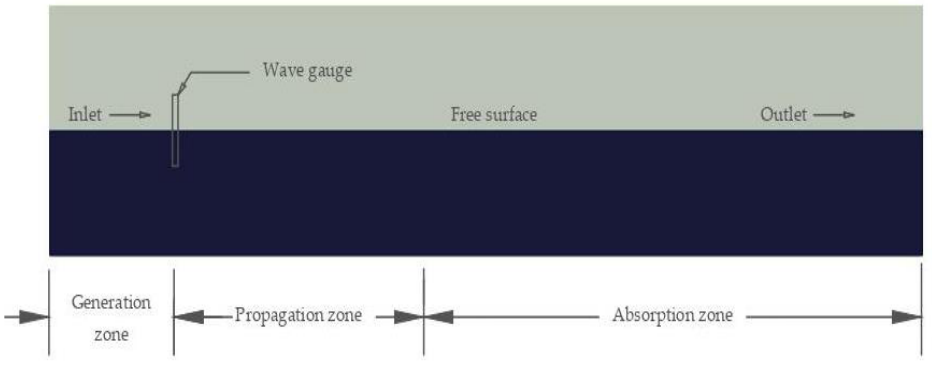
Figure 5. Schematic representation of zones in CFD numerical wave tank.